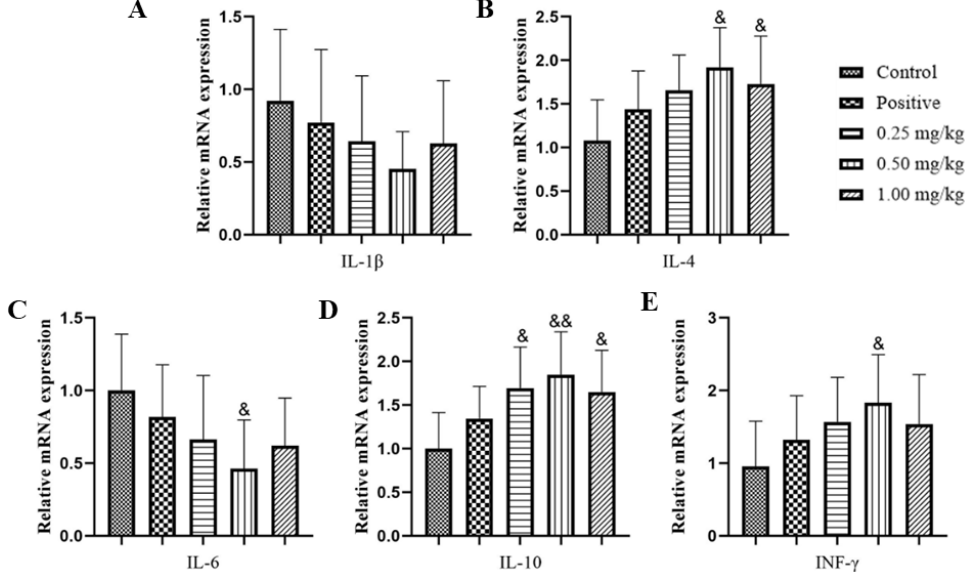
Figure 9. Expression of ( A ) IL-1 β ; ( B ) IL-4; ( C ) IL-6; ( D ) IL-10; and ( E ) INF- γ in the spleen of immunized mice administered with glycine nano-selenium and challenged with H9N2 avian influenza virus. Bars are represented as mean ± SD. Bars with same && or & are statistically the same (n = 5, p < 0.05 or p < 0.01). Control, received no immunization + 0.5 mL normal saline; positive, received H9N2 AIV vaccine + 0.5 mL 0.9% normal saline; 0.25 mg/kg group, received H9N2 AIV vaccine + 0.5 mL 0.25 mg/kg selenium solution; 0.5 mg/kg group, received H9N2 AIV vaccine + 0.5 mL 0.5 mg/kg selenium solution; 1 mg/kg group, received H9N2 AIV vaccine + 0.5 mL 1 mg/kg selenium solution.